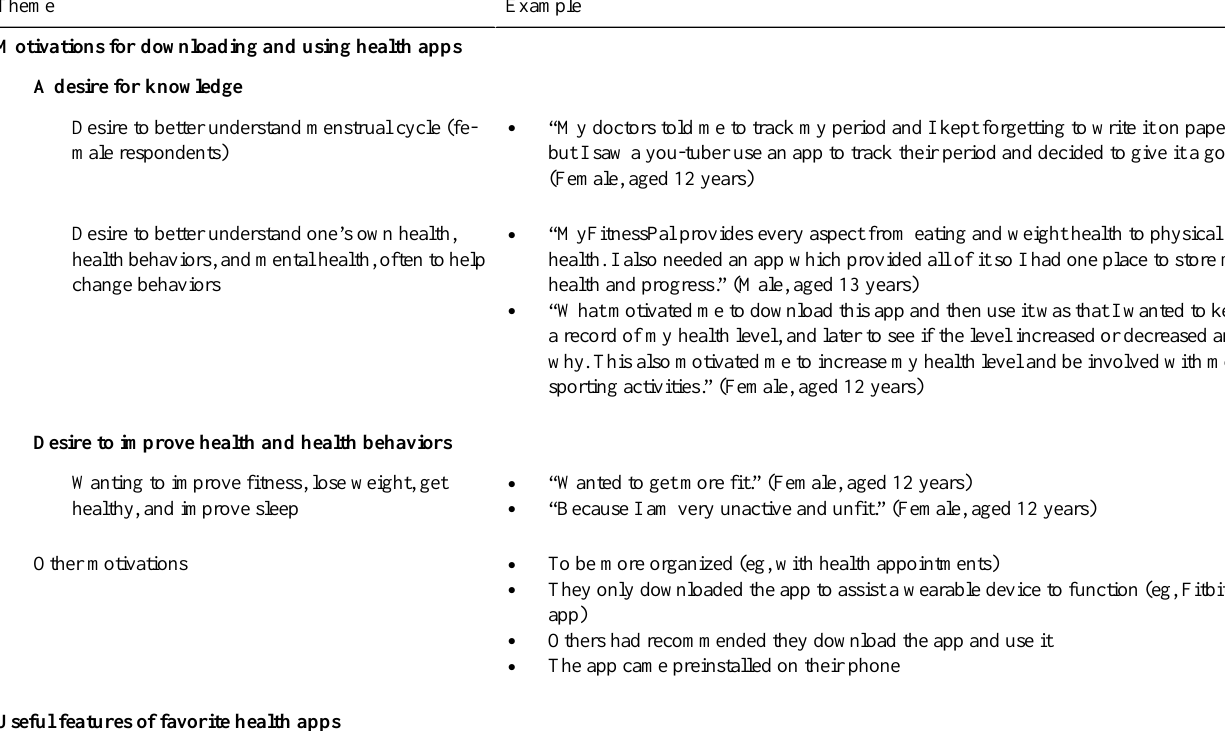
Table 3. Summary of key themes extracted from students’open-ended responses. ExampleTheme Motivations for downloading and using health apps A desire for